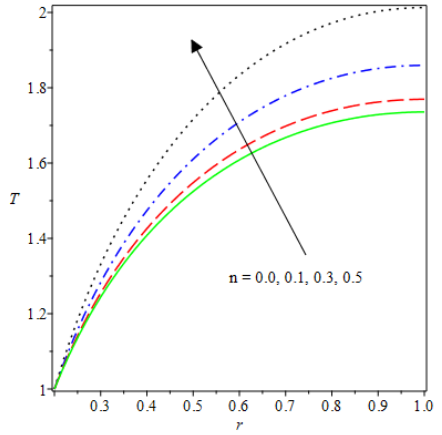
Figure 7. Heat transfer for different ( n ) .